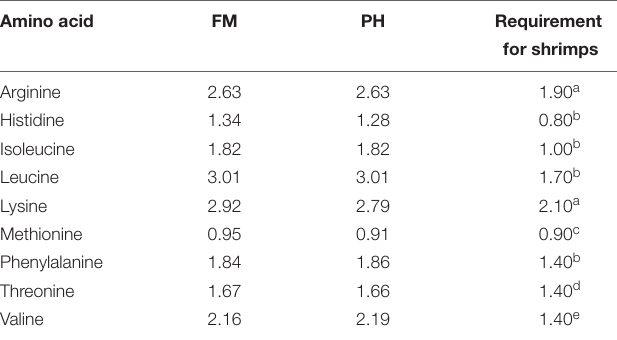
TABLE 4 | Essential amino acid profile (%) of experimental